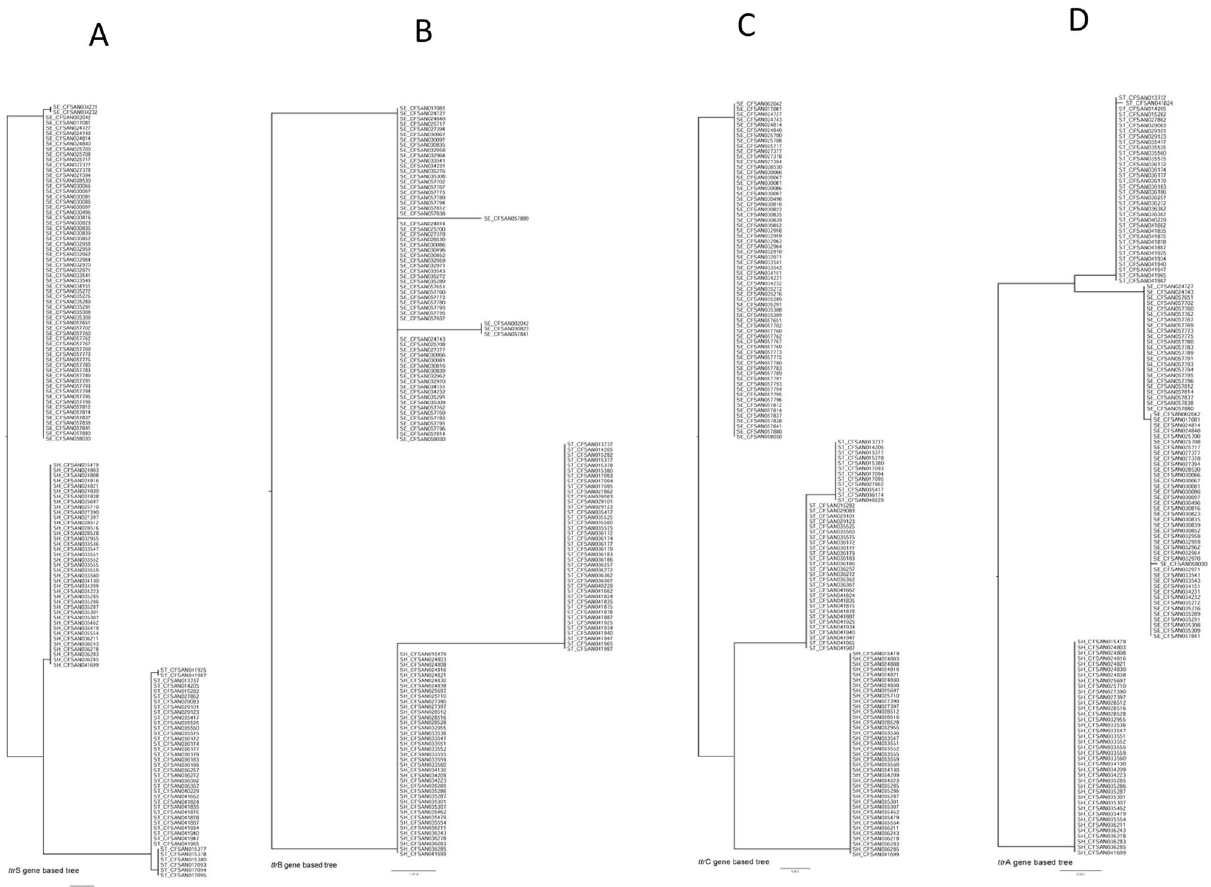
Figure 6. Phylogenetic trees of all sequenced Salmonella isolates based on the nucleotide sequences of the target genes ttr S ( A ), ttrB ( B ), ttrC ( C ), and ttrA ( D ). The trees were constructed by the neighbor jointing method using CLC Genomics Workbench. The scale indicates the sequence percentage of base distance (percent